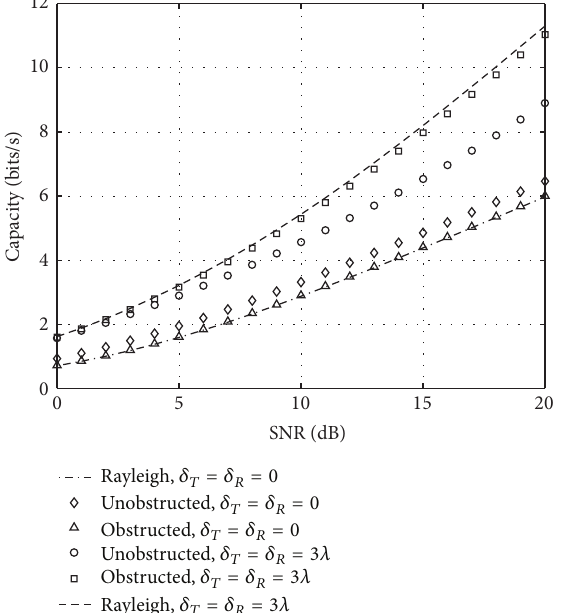
Figure 14: Ergodic capacities against SNR for SISO (𝛿 𝑇 = 𝛿 𝑅 = = 𝛿 = 3𝜆) cases in the obstructed and 0) and MIMO (𝛿 𝑇 𝑅 unobstructed